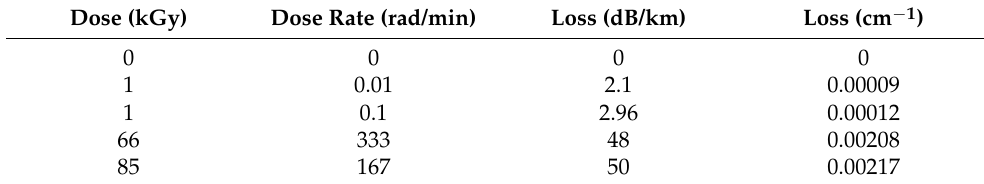
Table 6. RIA values obtained from [40,41]. Dose